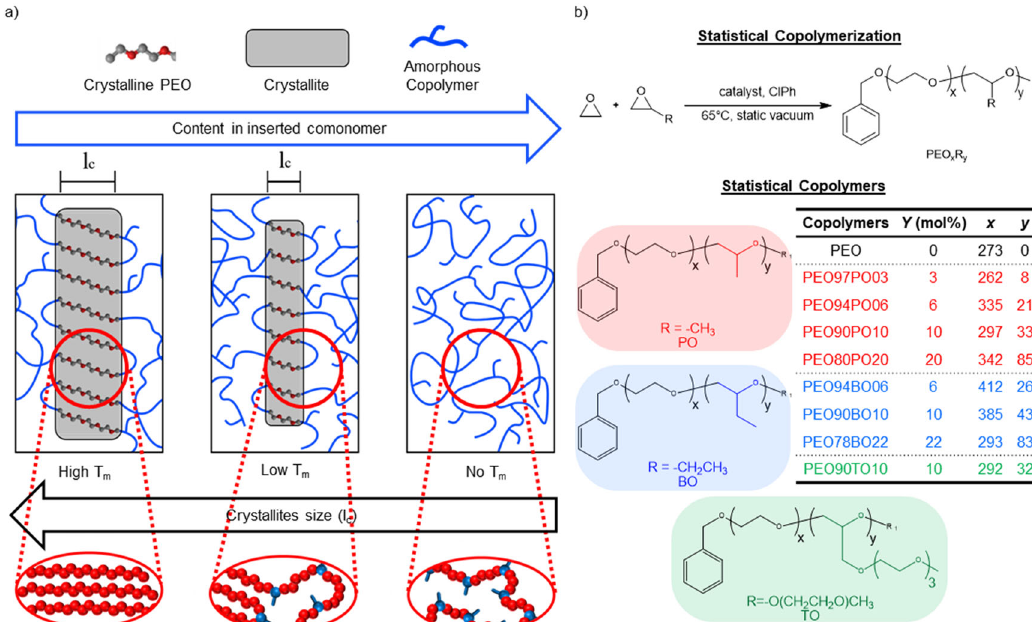
Fig. 1 Schematic representation of copolymer crystallinity. a Breaking of crystallinity with increased comonomer content, resulting in reduced crystallites size and lower melting temperature, and eventually leading to loss of crystallites, hence no crystallinity and no observable melting temperature. Sketches (in red ovals) represent the molecular arrangements with comonomer content. Ethylene oxide units are represented by red spheres and substituted epoxides by blue spheres with the substituent depicted as a blue bar. b General synthetic pathway for the design of statistical copolymers of ethylene oxide and substituted epoxides, including molecular structures of the three families of copolymers synthesized, along with their